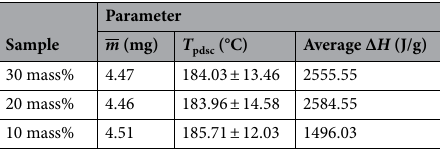
Table 3. Thermodynamic parameters of different NC-S concentrations measured by DSC experiment in an oxygen-free environment.